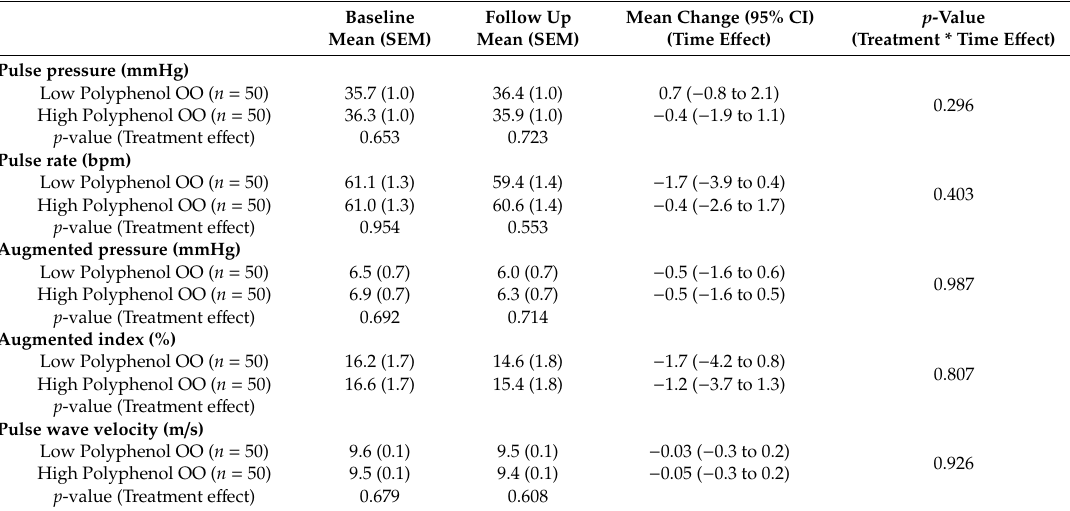
Table 4. E ff ect of low polyphenol OO vs. high polyphenol OO on mean changes in hemodynamic and arterial sti ff ness indices.